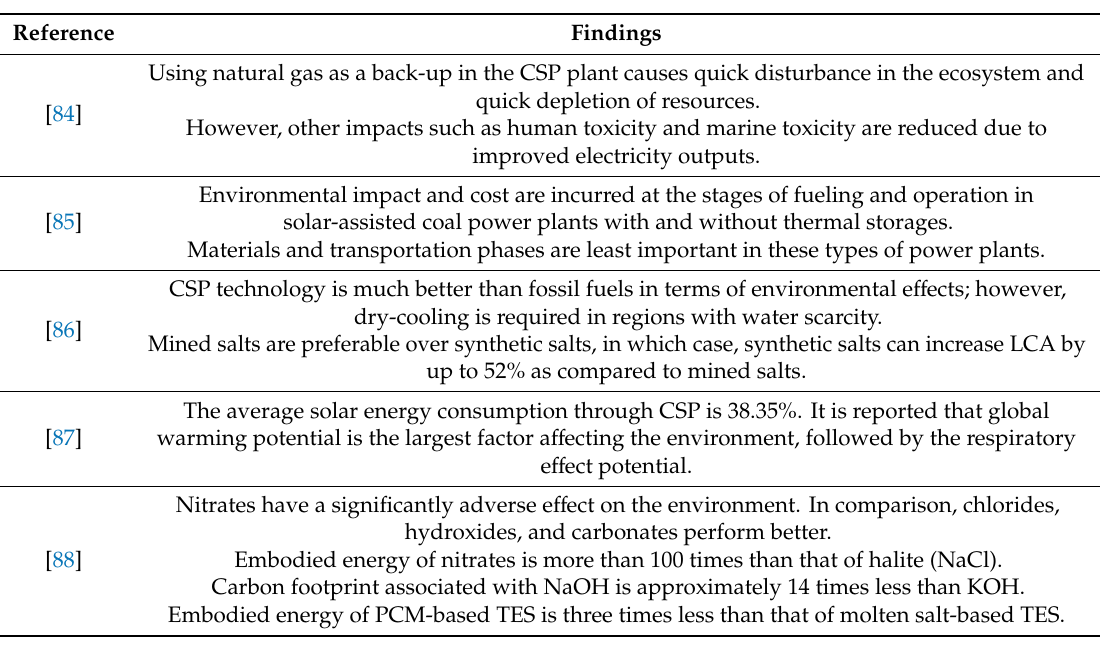
Figure 4. Comparison of the three power plants using the single score indicator [78].